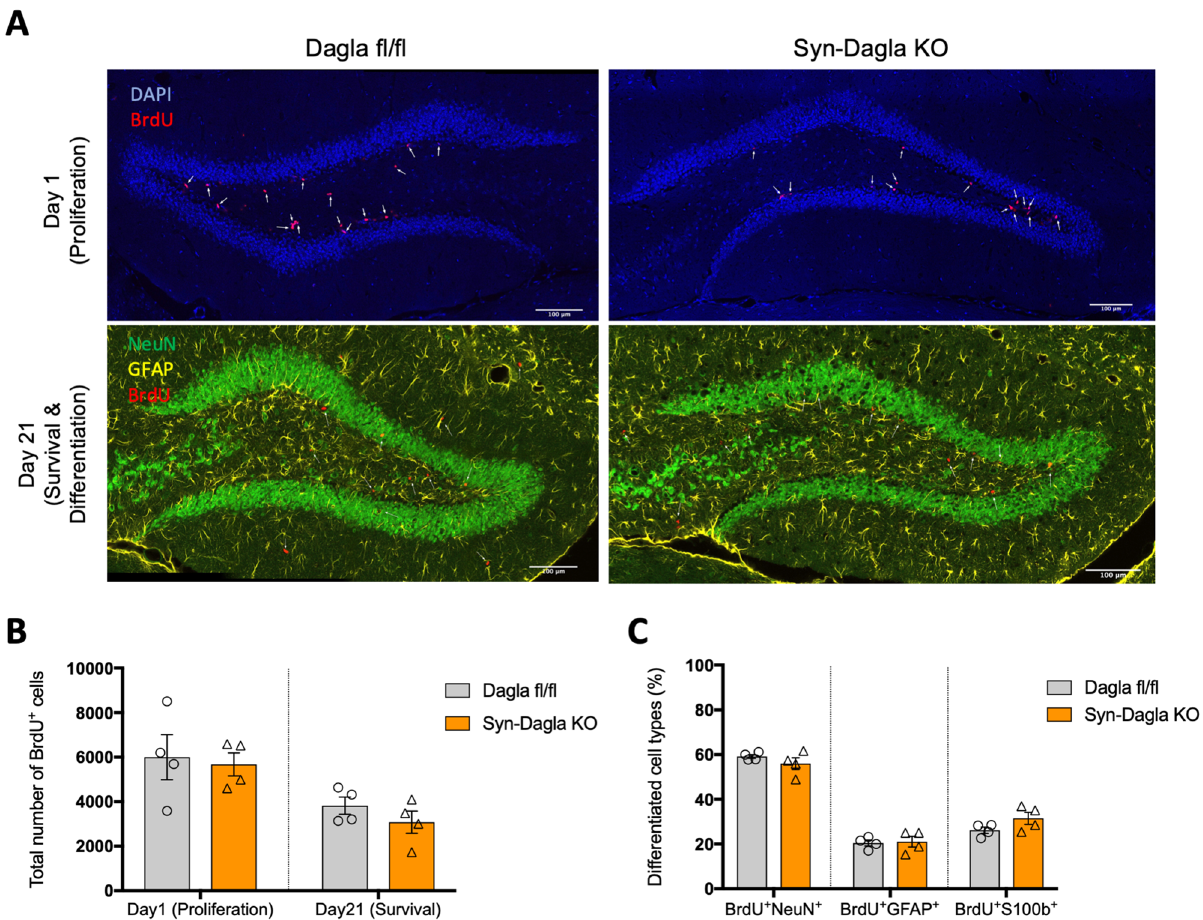
Figure 5. Adult hippocampal neurogenesis is not altered in Syn-Dagla KO mice. ( A ) Representative immunohistochemistry stainings of Syn-Dagla KO and control mice. Syn-Dagla KO mice show similar number of BrdU-positive cells (red) 1 day after the last injection. 21 days after BrdU injections, the number of BrdU positive cells does not differ between Syn-Dagla KO mice and controls. Additionally, brains were stained with an astrocytic marker GFAP (yellow) and a neuronal marker NeuN (green) to investigate differentiation, which was unchanged (scale bar: 100 µm). ( B ) The number of BrdU-positive cells in dentate gyrus of Syn-Dagla KO mice was similar to controls, one and 21 days after BrdU injections. ( C ) Differentiation of progenitor cells in dentate gyrus of Syn-Dagla KO mice. BrdU-positive cells were analyzed for co-expression of neuronal marker NeuN and astrocytic markers GFAP and S100beta. Values represent mean ± SEM; n = 4 animals/group, 6 analyzed pictures/ animal. Student’s